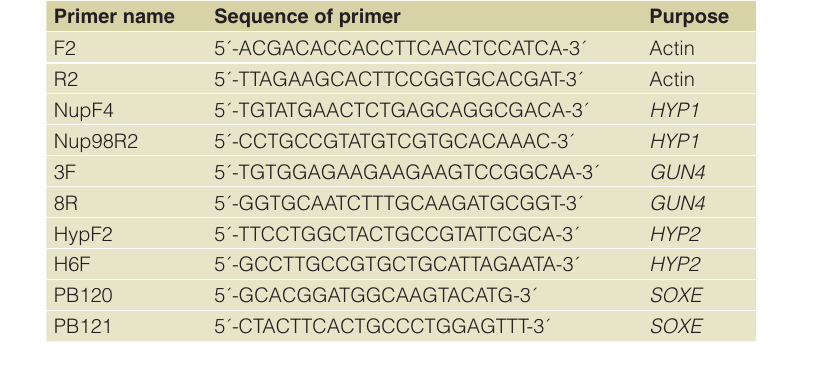
Table 5. List of primers used for cloning and complement testing. These primers were used in the experiments that generated the data in Figure 8 and Figure 11 and were also used for GUN4 gene amplification for